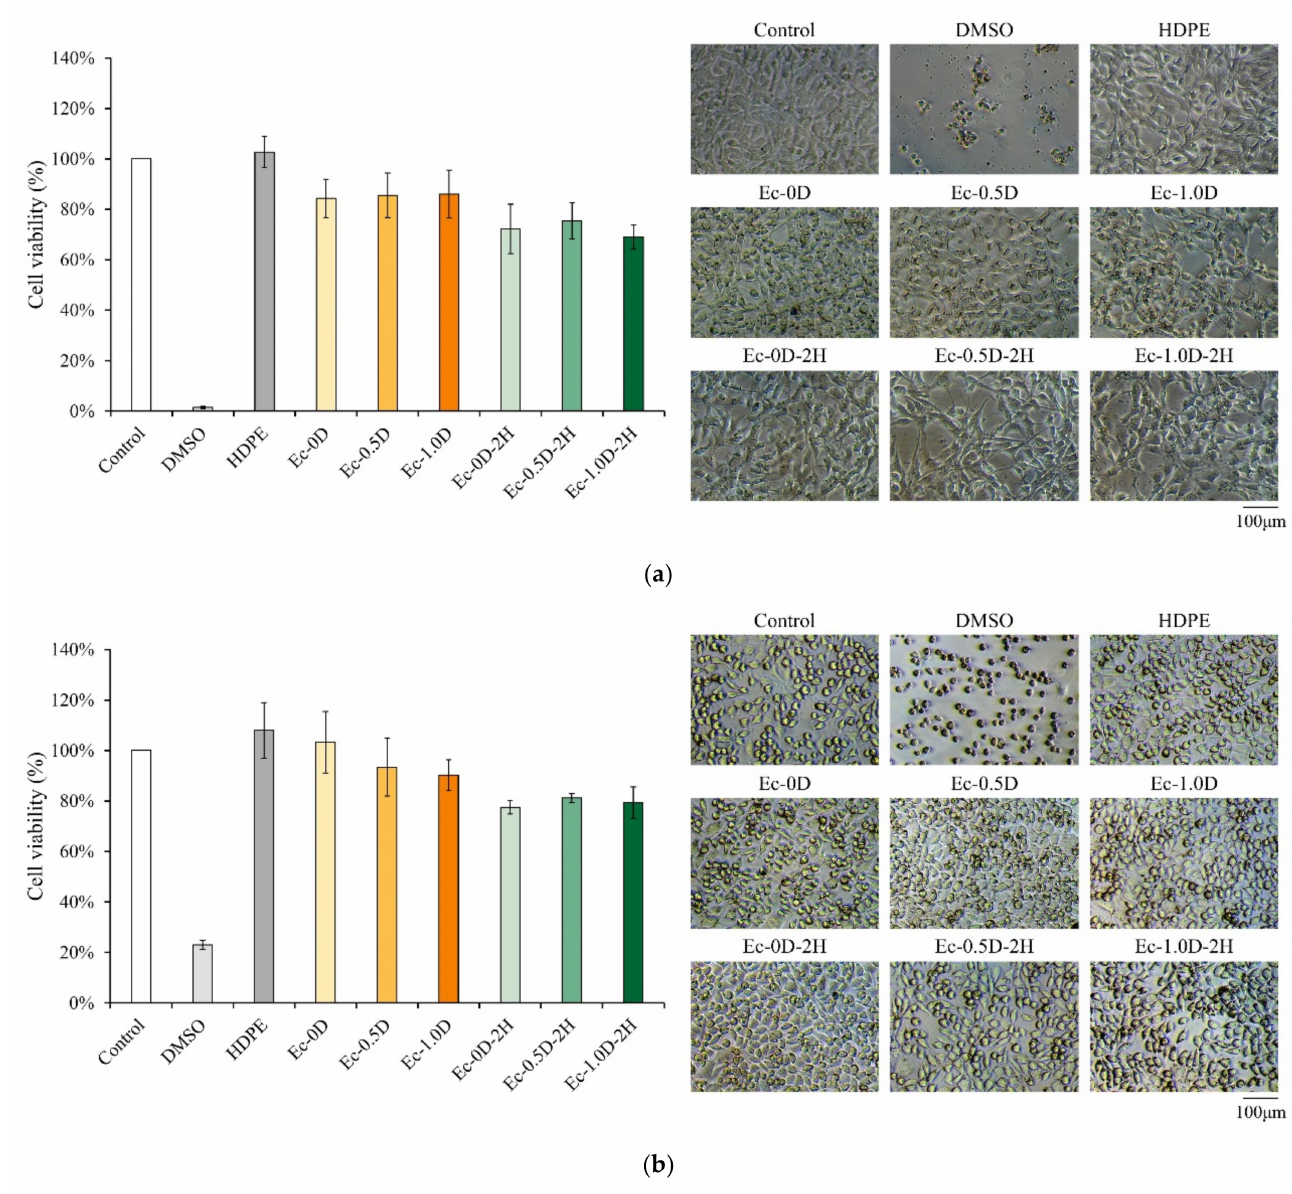
Figure 8. Quantitative (left, n = 6) and qualitative (right) cell images of the cytotoxicity of NIH-3T3 ( a ) and L929 ( b ) fibroblasts through different hydrogel membrane extracts (DMSO for positive control and HDPE for negative control). Figure 8a,b present optical images of NIH-3T3 and L929 cells cultured in the